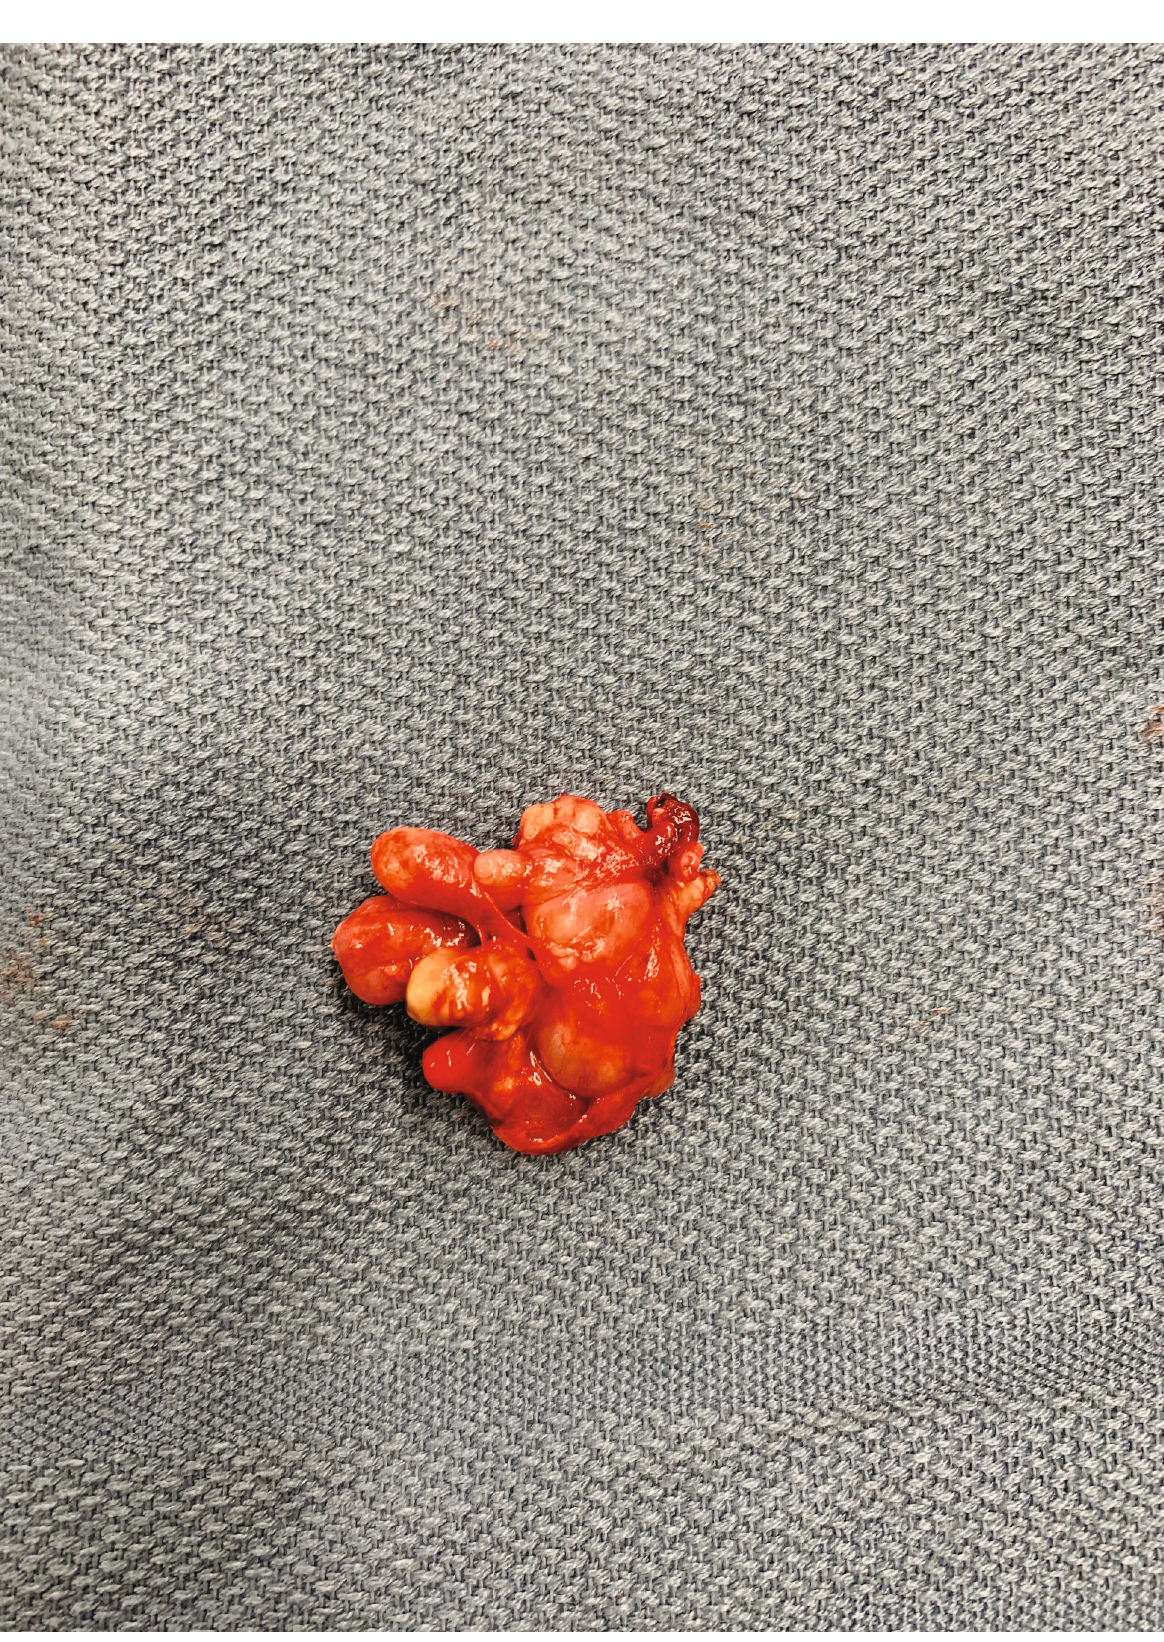
Figure 3: Intraoperative photograph of the resected